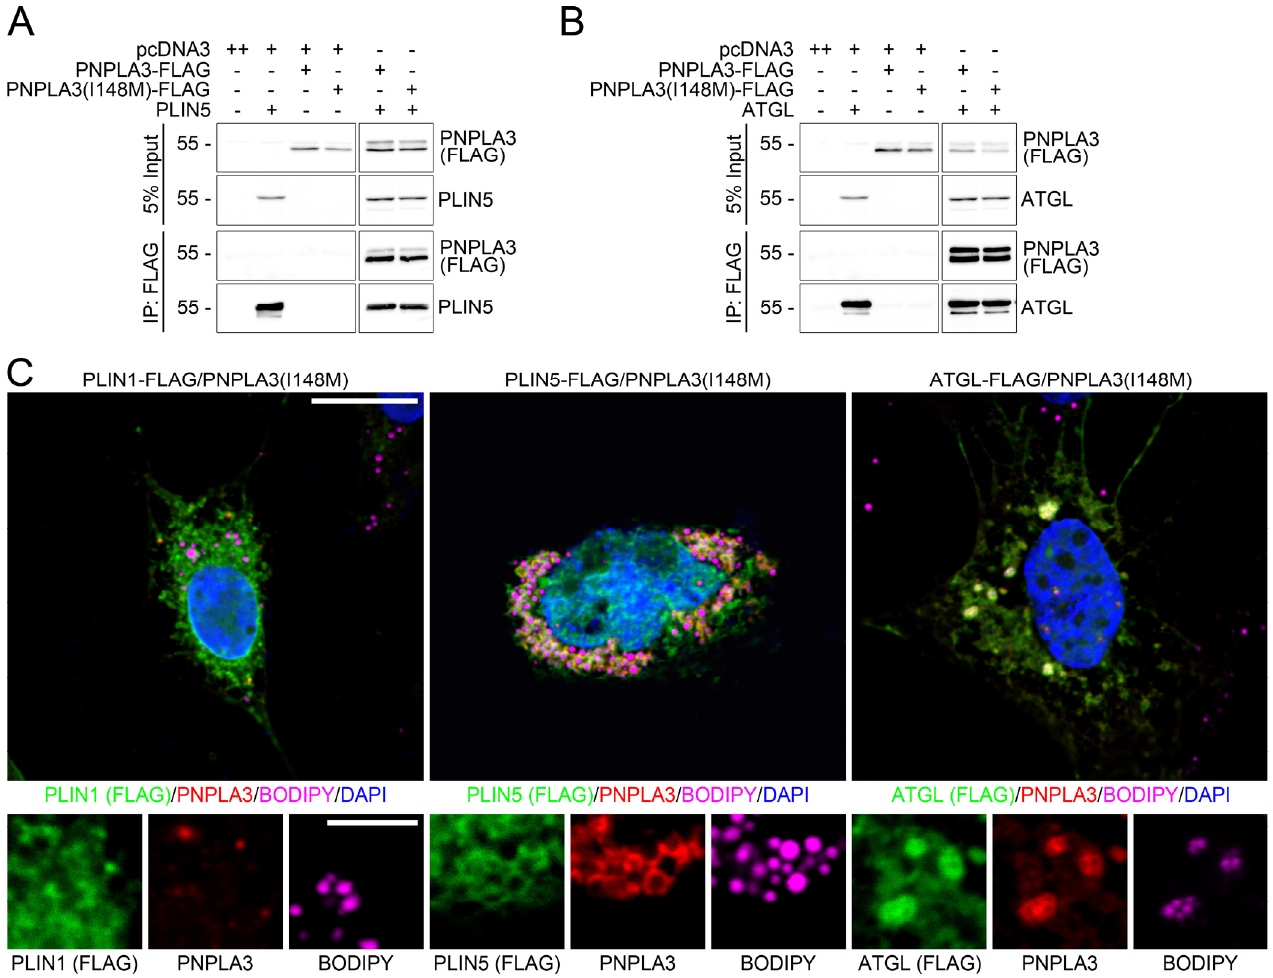
Figure A6. PNLA3 and PNPLA3(I148M) show identical interaction properties at the protein level and localization effects. Immunoblot analysis of PNPLA3, perilipin 5 (FLAG) and ATGL of Co-IP experiments of FLAG-tagged PNPLA3 and PNPLA3(148M). HEK293T cells were transfected with PNPLA3 or PNPLA3(I148M) alone and together with either FLAG-tagged PLIN5 ( A ) or ATGL ( B ). PNPLA3(I148M) showed an equal interaction behavior with PLIN5 or ATGL compared to PNPLA3. Molecular weight (kDa) is given on the left. ( C ) Immunofluorescence microscopy of perilipin 1 (PLIN1, green, left), perilipin 5 (PLIN5, green middle), or ATGL (green, right) with PNPLA3(I148M) (red) in transfected HepG2 cells (LDs: BODIPY, violet; nuclei: DAPI, blue). HepG2 cells were transfected with PNPLA3(I148M) alone or together with FLAG-tagged PLIN1, PLIN5, or ATGL and subsequently stained with antibodies against PNPLA3 and the FLAG epitope. Both the effects of PNPLA3(I148M) on the localization of perilipins and the effects of perilipins on PNPLA3(I148M) were indistinguishable from PNPLA3. Scale bars: 15 µm and 5 µm for magnified images.